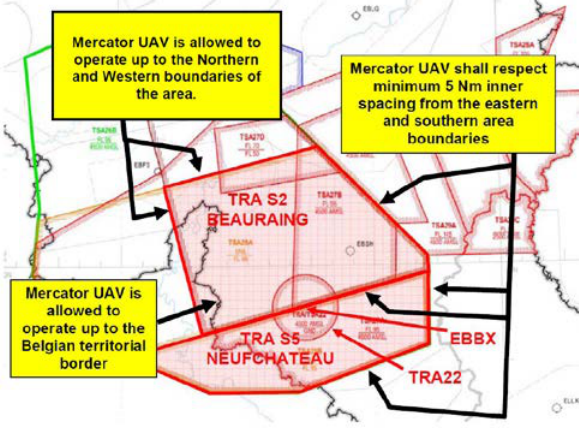
Figure 2. Airspace available for Mercator Neufchateau in Figure 2.), measuring about 55 km East-to-West and North-to-South The flight crew would have to deal with this restriction and keep the aircraft within its containment area.